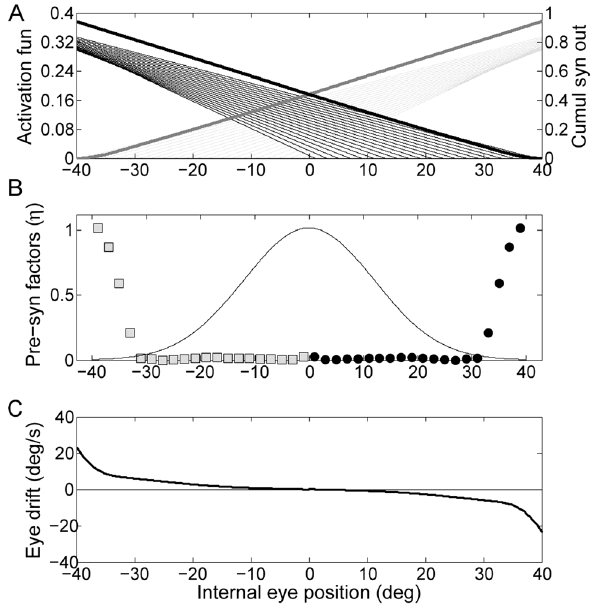
Figure 7. Simulation of the network tuned favoring leakiness against instability. The inverse of the Gaussian function of the eye eccentricity shown by the solid line in the central panel has been used as a gaze-dependent threshold for the non-penalized drift during the optimization procedure. The contents of the panels are as in figure 1A.